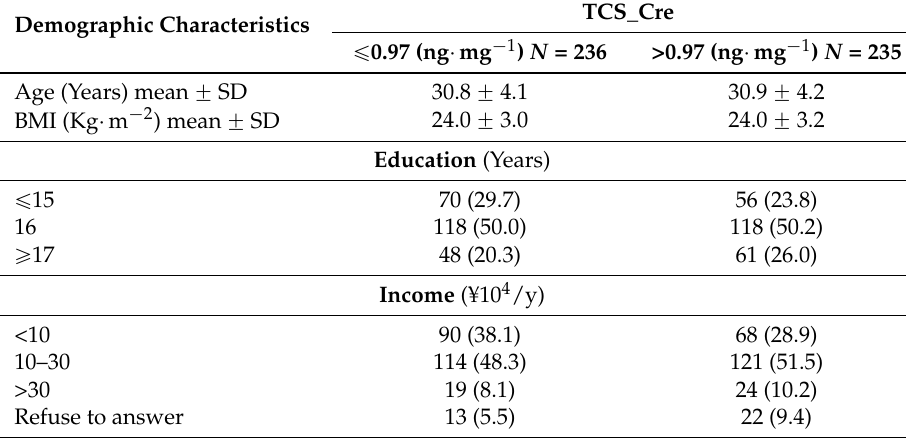
Table A2. Distribution of baseline characteristics by creatinine-corrected urinary triclosan (TCS) concentration